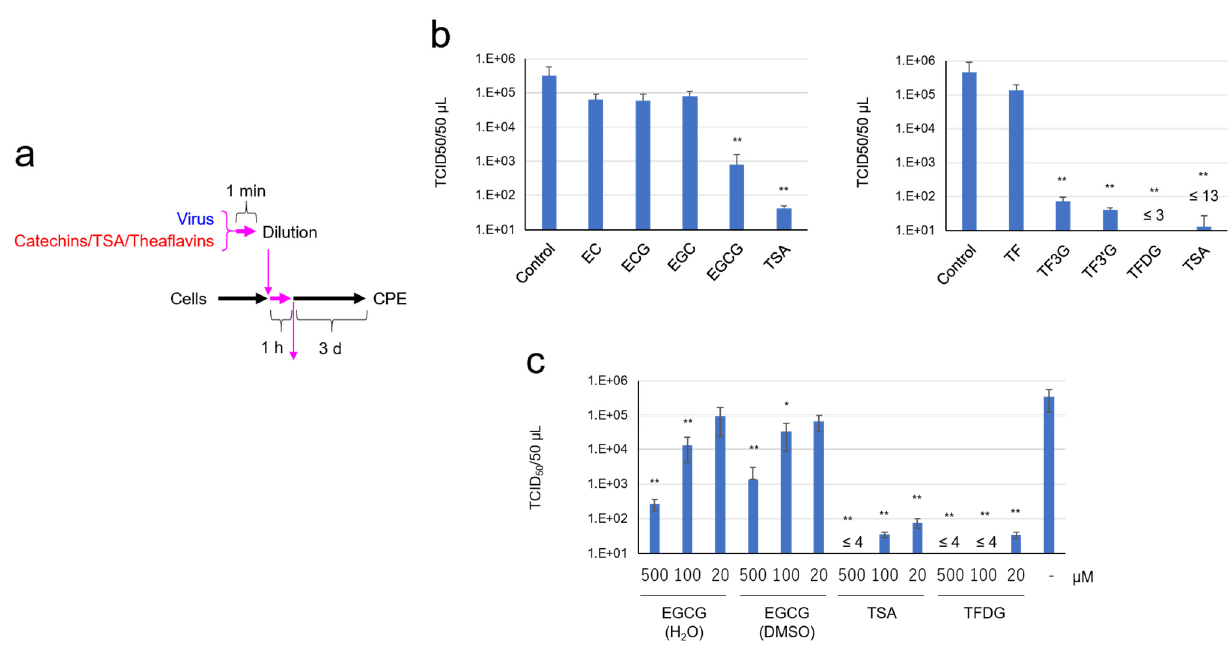
Figure 3. EGCG and galloylated theaflavins significantly decreased SARS-CoV-2 titer. Virus was treated with 500 µM ( b ) or the indicated concentrations ( c ) of tea catechins, a catechin-derivative, and theaflavins for 1 min, immediately followed by a 10-fold serial dilution and infection into VeroE6/TMPRSS2 cells to measure TCID 50 values as in Figure 1. Scheme of experiments ( a ) and virus titer of each sample ( b , c ) are shown. Values are means ± S.D. ( n = 3). * p < 0.05 and ** p < 0.01 vs. Control by Tukey’s multiple comparison test.